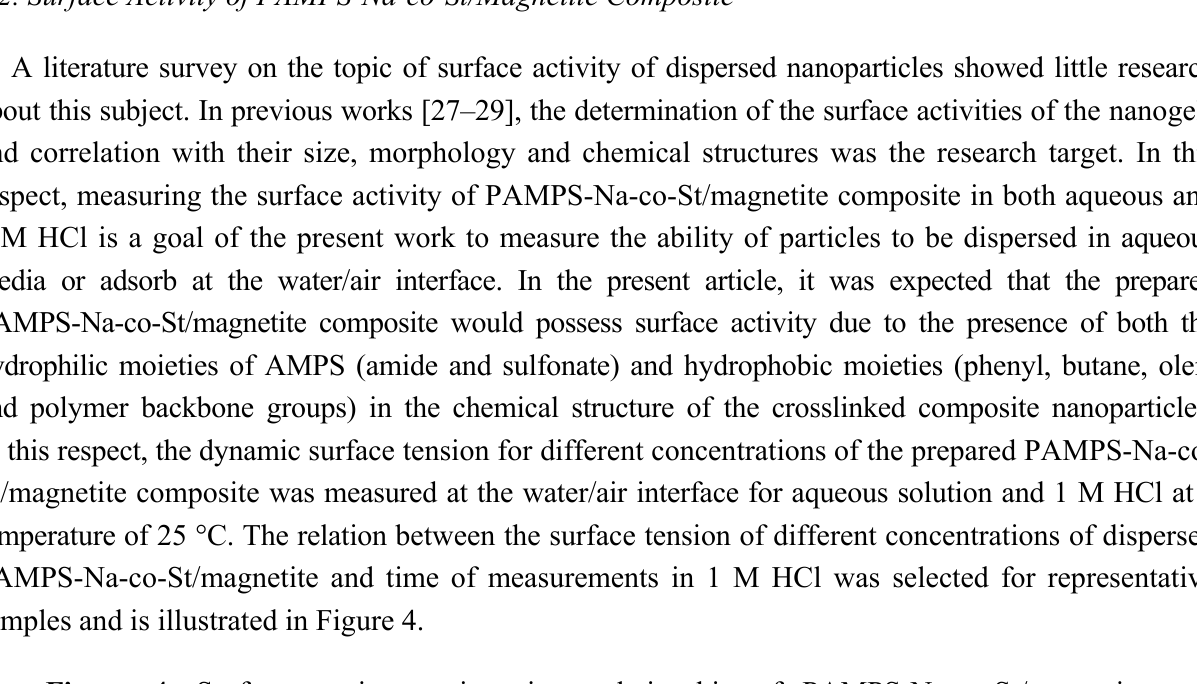
Figure 4. Surface tension ageing time relationship of PAMPS-Na-co-St/magnetite composites of different concentrations in 1 M HCl at 25